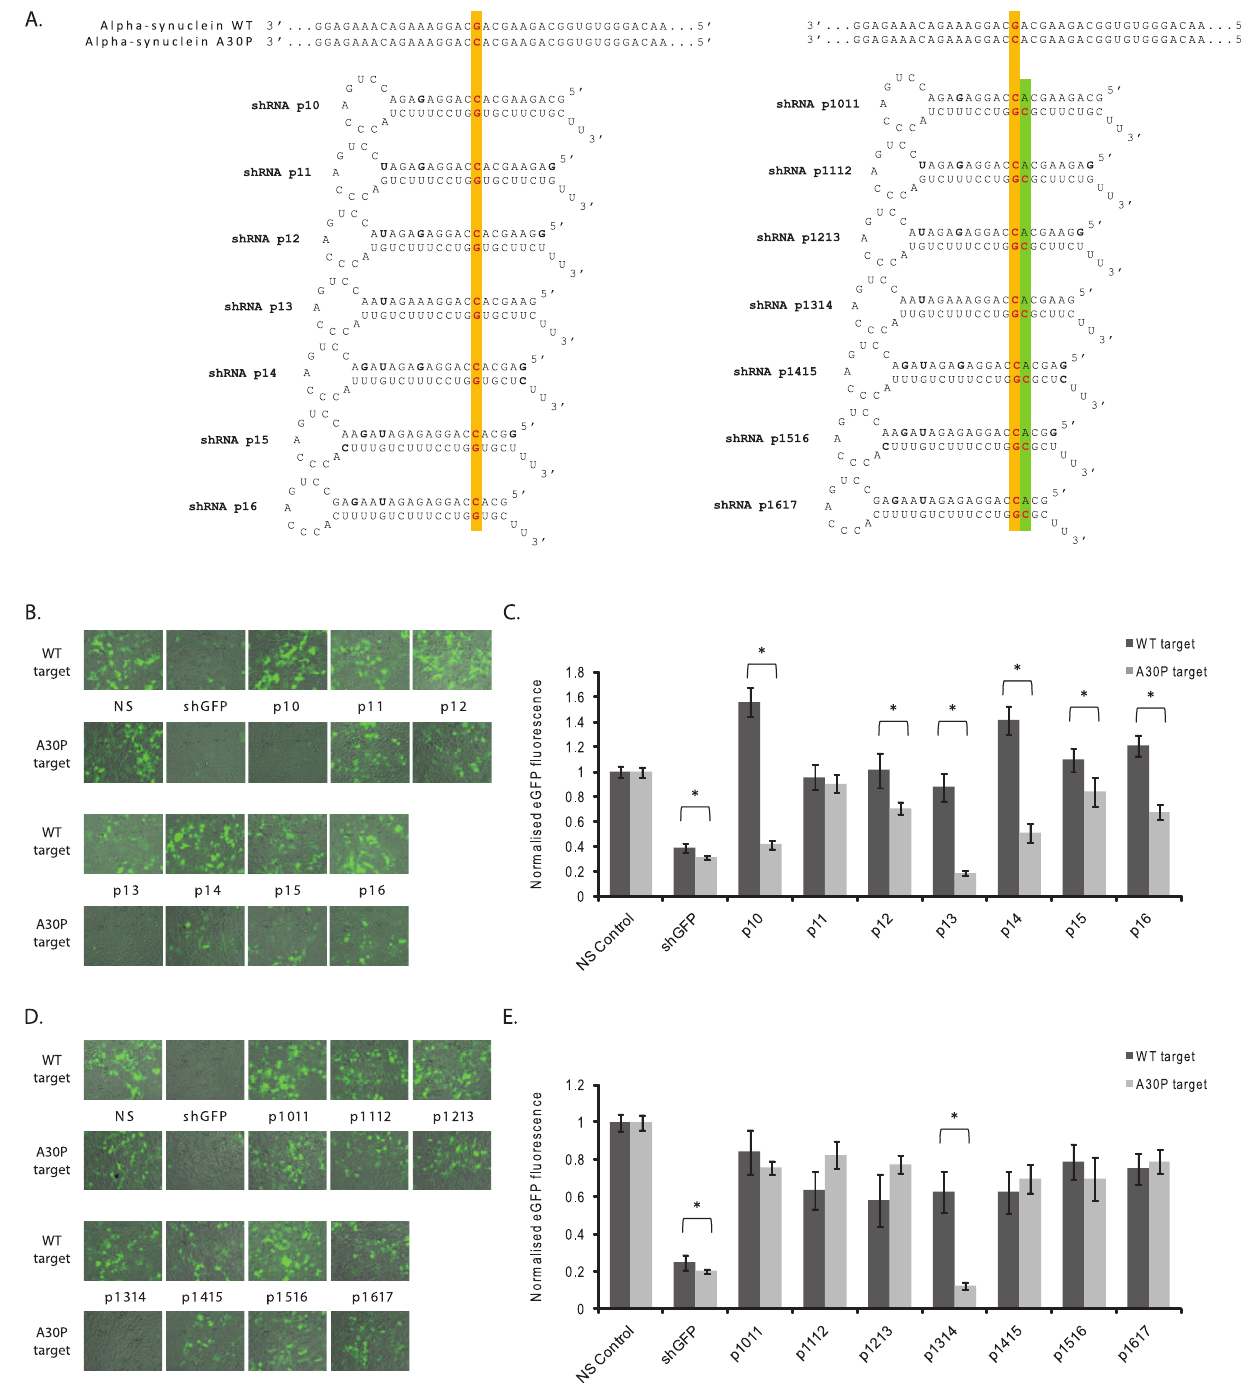
Figure 1. Screening of A30P-targeting shRNAs against full-length eGFP-tagged a -synuclein targets. A) shRNAs were designed targeting the A30P mutant allele of a -synuclein with the A30P mutation aligned at sequential positions in the 3 9 region of the antisense species from positions 10–16 (P10-P16). In some shRNAs a secondary mismatch to the wild-type allele was additionally made immediately 3 9 of the primary mismatch such that two mismatches are present to the wild-type target, and one mismatch to the A30P mutant target. B + D) Representative fluorescent images of HEK-293 cells co-transfected with stated eGFP-tagged a -synuclein targets and indicated single (B) or double (D) mismatch shRNA construct at 72 hrs post-transfection. C + E) Quantification of eGFP fluorescence at 72 hrs post-transfection following co-transfection of single (C) or double (E) mismatch shRNAs targeting the A30P a -synuclein mutant with wild-type (dark) or mutant (light) eGFP-tagged a -synuclein targets. Values represent mean ratios of normalized fluorescence + / 2 S.D. from n=6. Values are normalized to cells transfected with non-specific shRNA and respective eGFP-tagged target. *=P , 0.05 relative to respective normalising control.